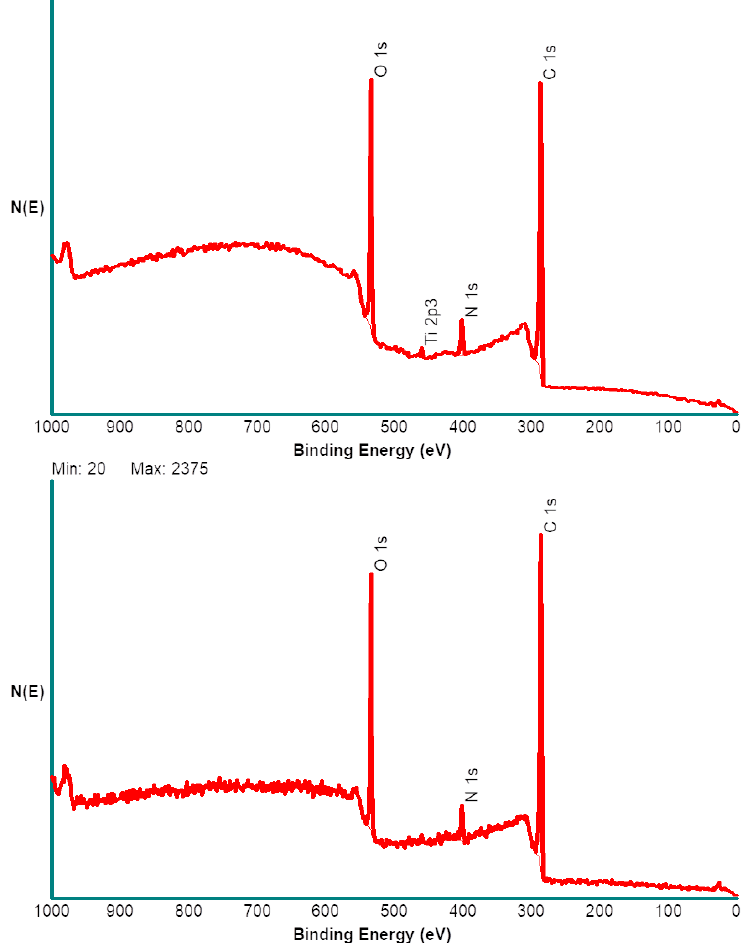
Figure 3. XPS spectra of Ti-PDA-aPEG-EGCg samples acquired at grazing (15°, bottom) and high (75°, top) take-off angle.